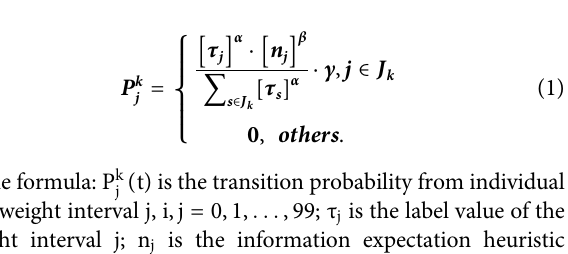
FIGURE 12 | August 3 ZEN, NANO, and WRX Popularity Value vs. Six Index